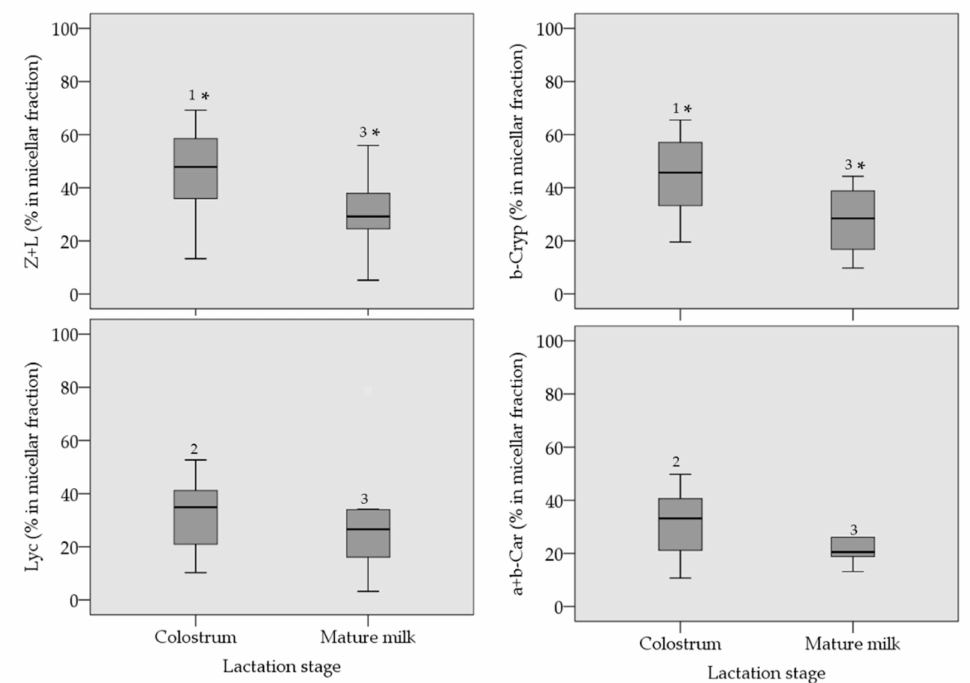
Figure 3. Micellar carotenoid contents (median percentage values ± 75th percentile) in colostrum and mature milk. Data were analyzed using non-parametric statistical procedure. Data denoted with the same number were not significantly di ff erent, both for colostrum and mature milk (Wilcoxon test, p > 0.05). Data denoted with an asterisk were significantly di ff erent (Mann–Whitney test, p <